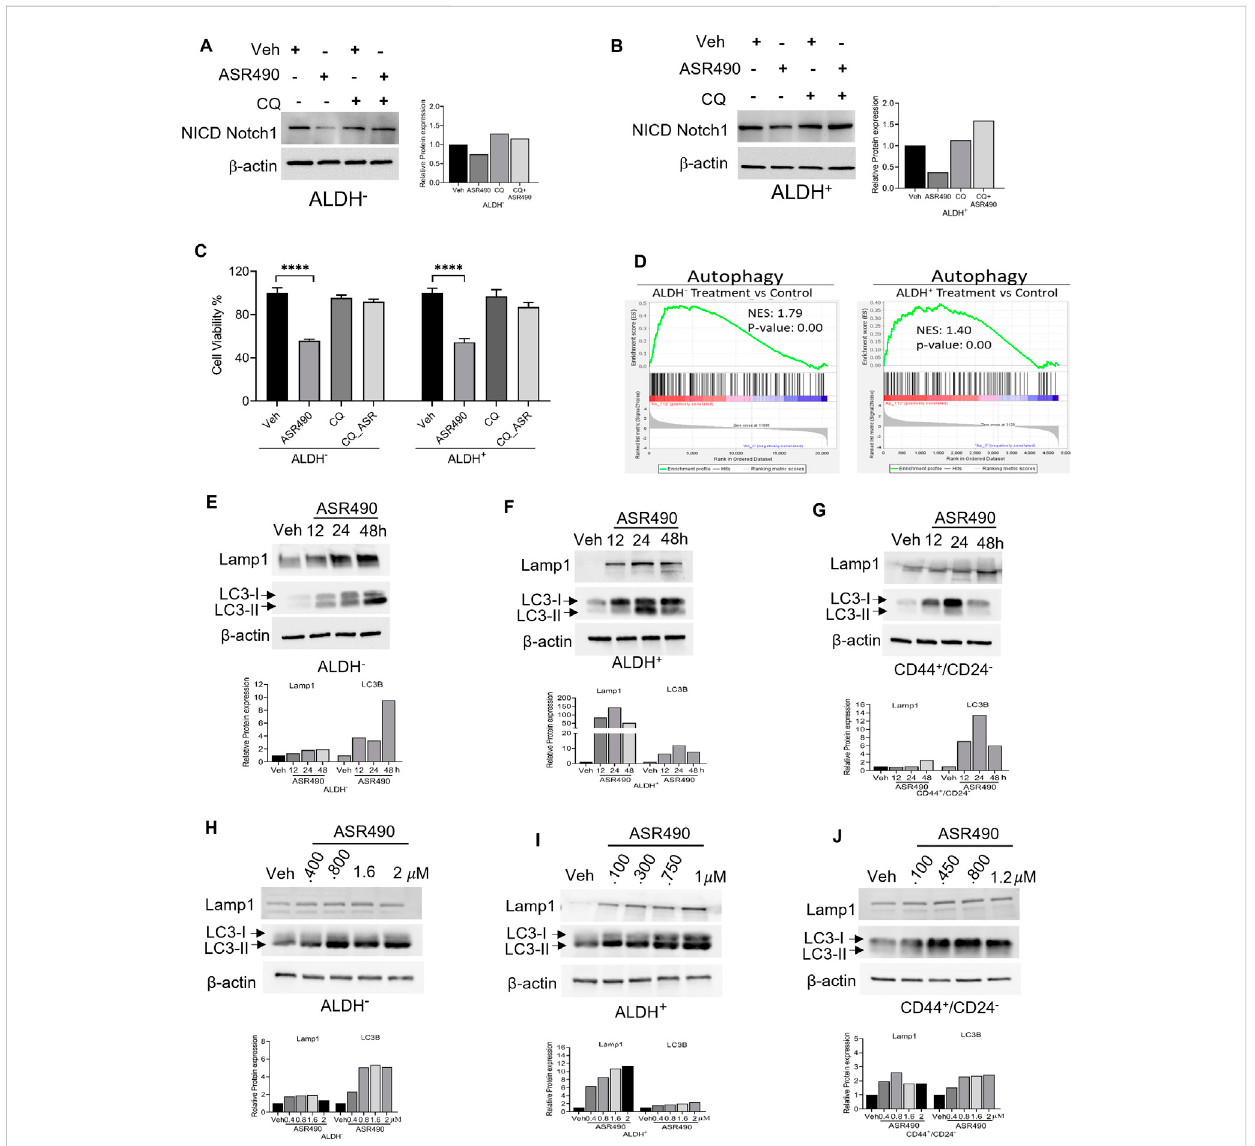
FIGURE 5 ASR490 abrogates both breast cancer and BCSC growth by activating autophagy pathways. (A, B) Western blots for Notch1-NICD expression in ALDH − and ALDH + cells treated withASR490, CQ(50 µM), orcombinations attheindicatedtime points. (C) MTT cell viability assays performedon ALDH − and ALDH + following treatment with ASR490, CQ, or combinations. ( n = 6; **** p < 0.0001). p values are based on one-way ANOVA with the post hoc Tukey test. (D) GSEA of RNA-seq data demonstrating downregulation in autophagy-regulated genes in ASR490-treated ALDH + and ALDH − cells. (E – J) . Western blots showing time- (E – G) and dose-dependent (H – J) effects of ASR490 treatment on autophagy markers Lamp1 and LC3B in ALDH − , ALDH + , and CD44 + /CD24 −